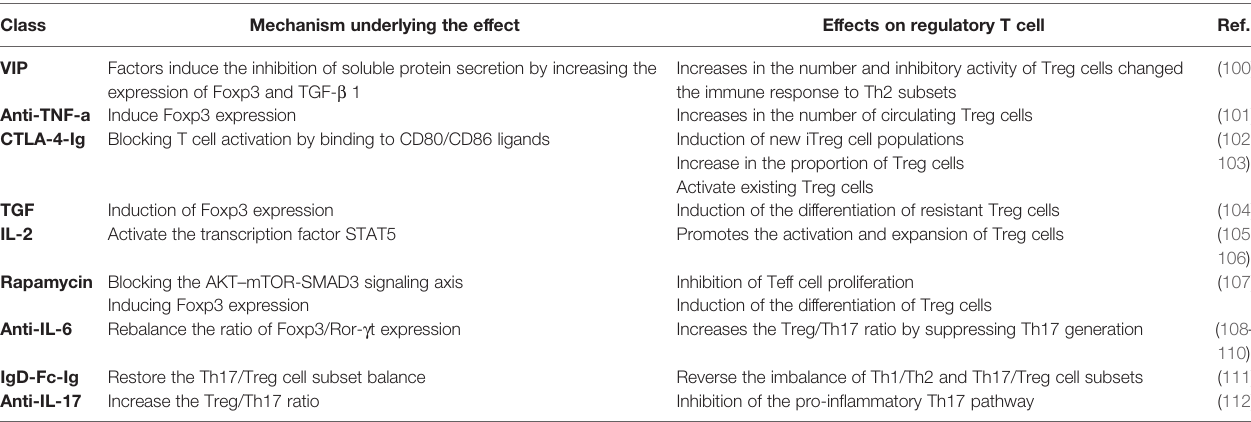
TABLE 2 | The mechanisms by which the number or function of Treg cells is